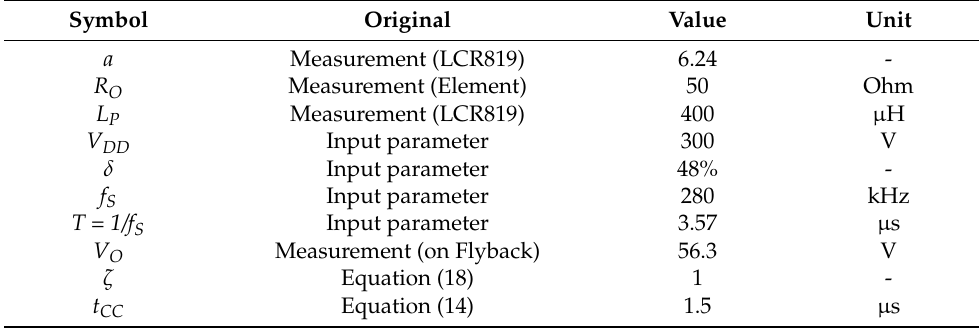
Table 2. Parameters used to estimate output